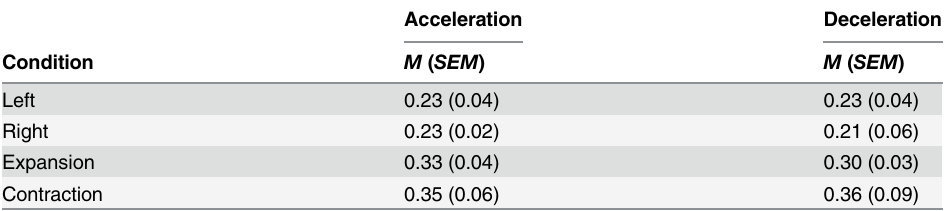
Table 2. Mean Slopes (Absolute Values) of the Psychometric